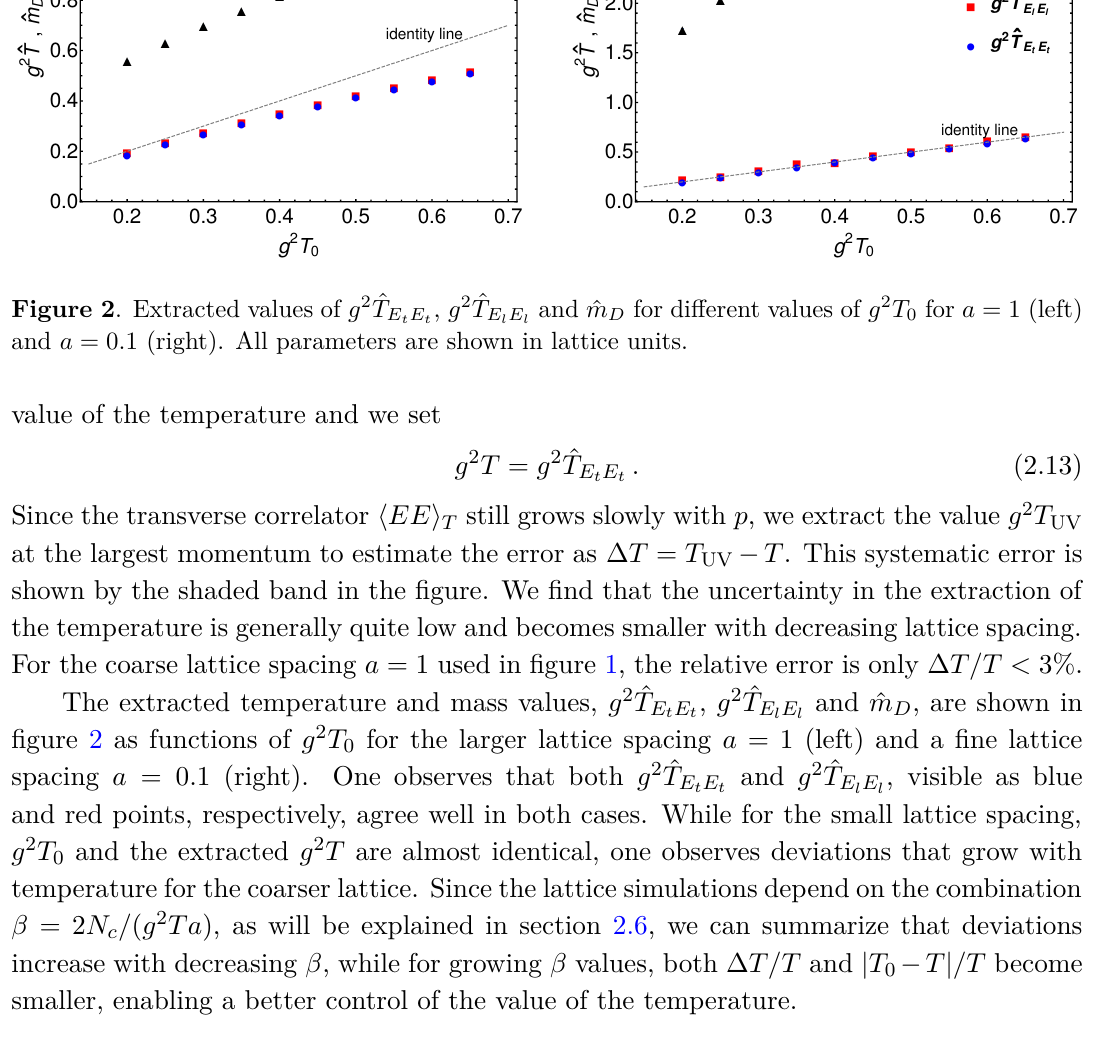
, g 2 ˆ T E and ˆ m D for different values of g 2 T 0 for a = 1 (left) t E t l E l